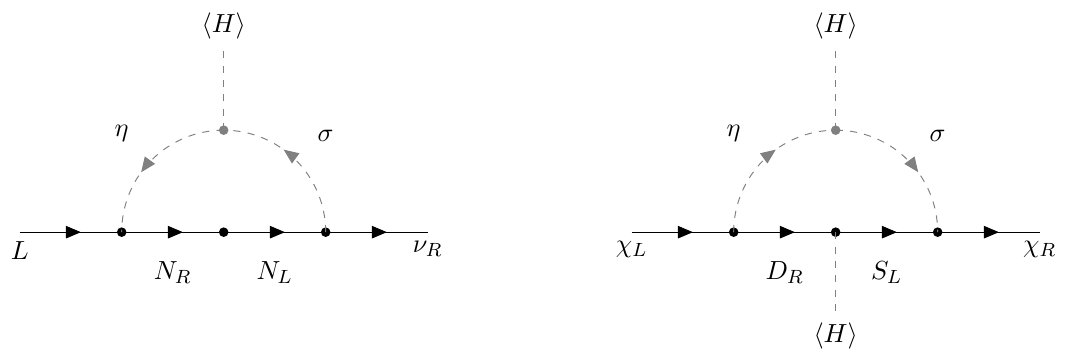
Figure 1 . Feynman diagrams in the gauge basis responsible for the creation of the neutrino and dark matter ( χ ) Dirac masses at the one loop